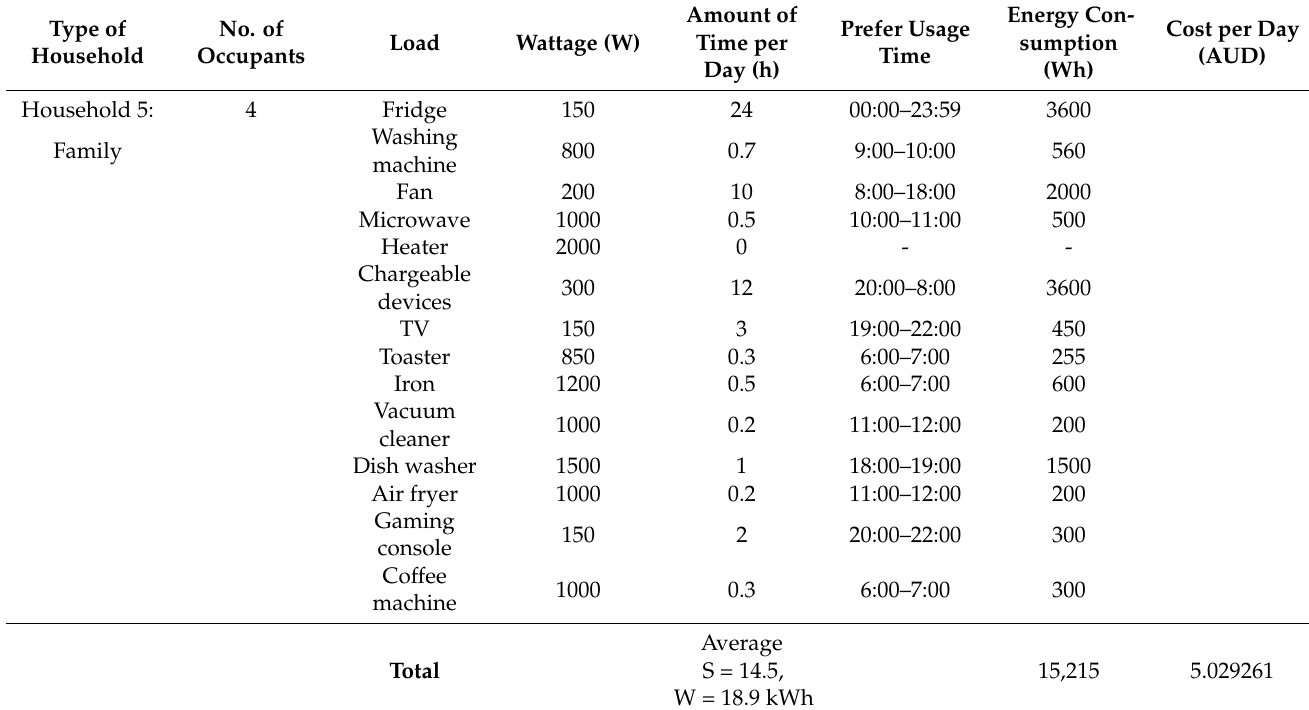
Table 7. Initial load profile 5 created for the project (summer).